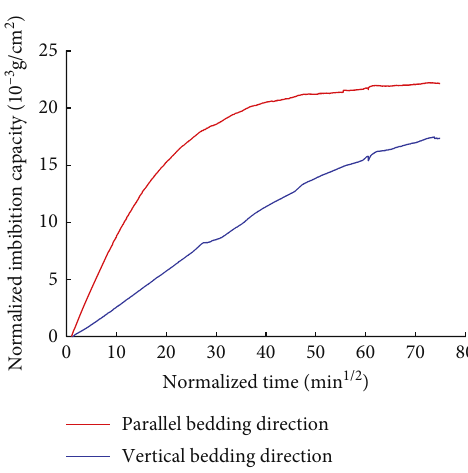
Figure 3: Spontaneous imbibition character of reservoir shale.